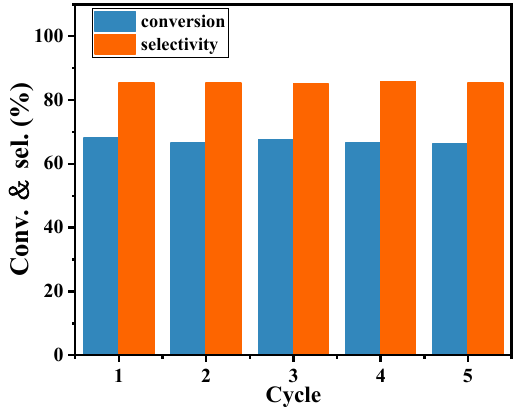
Figure 5. Recycling tests of selective hydrogenation of cinnamaldehyde over Ni 4 -La 2 O 3 catalyst. Reaction conditions: 0.8 mmol CAL, 50 mg catalyst, 6 mL absolute ethanol as solvent, 2 MPa H 2 , reaction temperature 90 ℃ , reaction time 2 h.